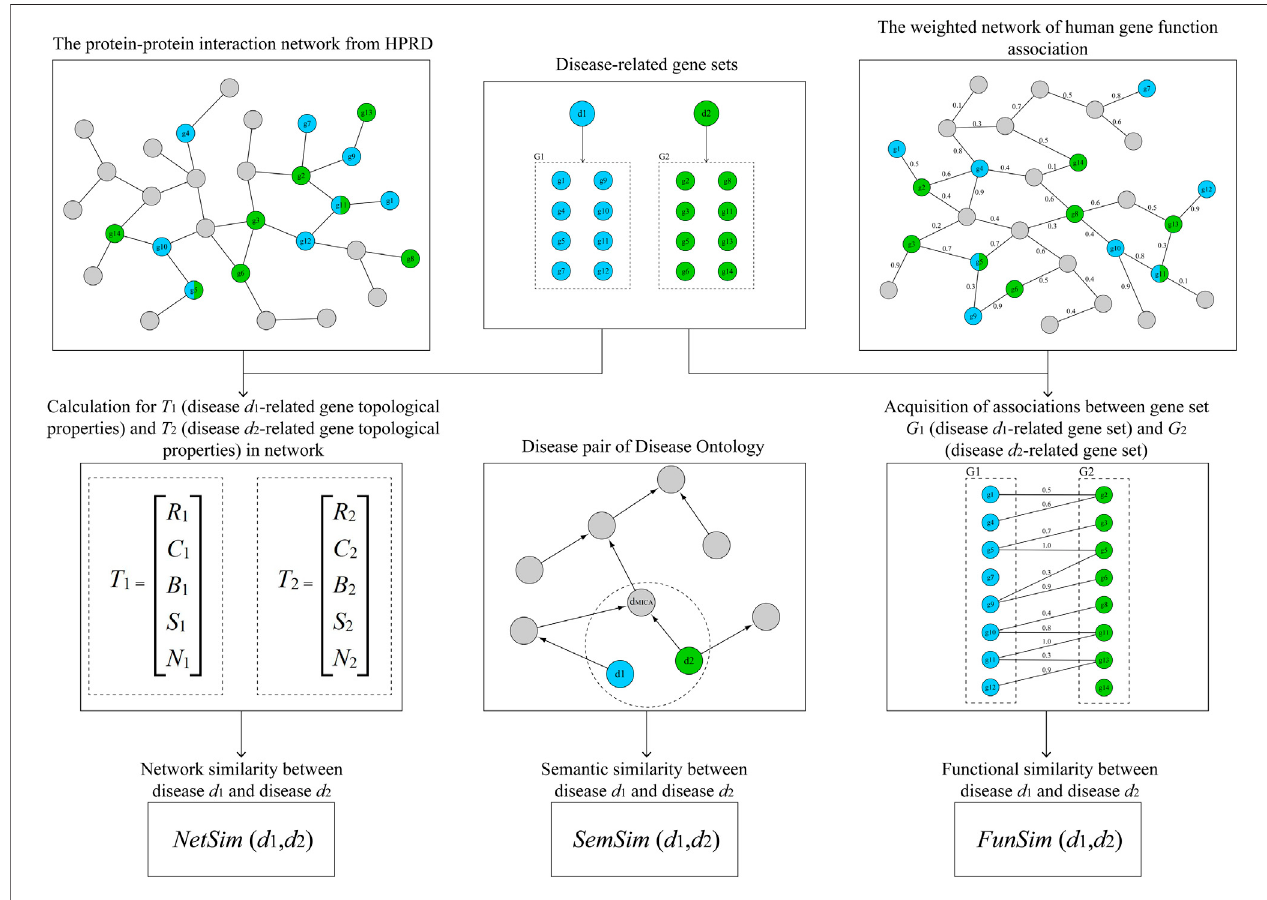
FIGURE 1 | The work fl ow diagram for this